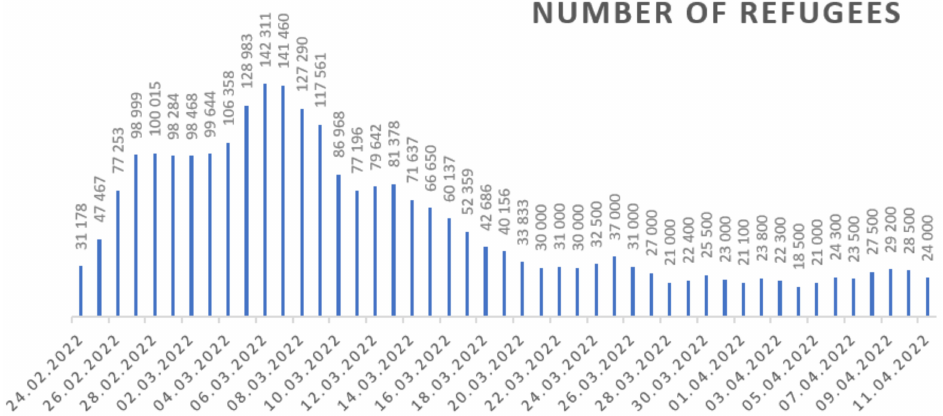
Figure 2. Number of refugees who crossed the Ukrainian–Polish border on 24 February 2022–11 April 2022. Source: own study based on daily data published by the Border Guard